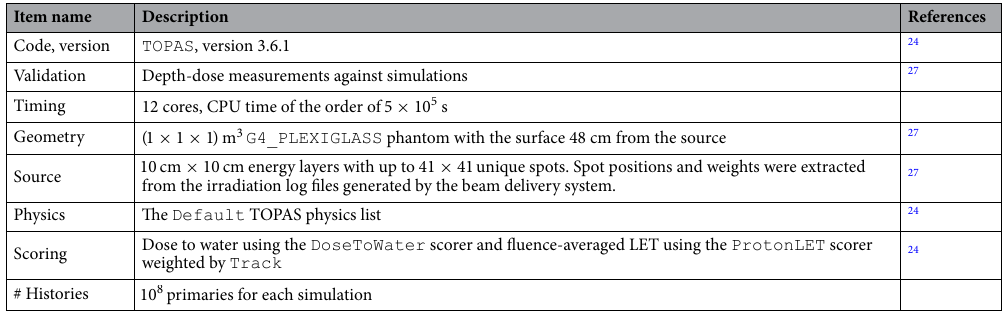
Table 2. Summary of the Monte Carlo simulation parameters used to calculate the dose and LET distributions in the proton fields. The number of energy layers varied with the proton